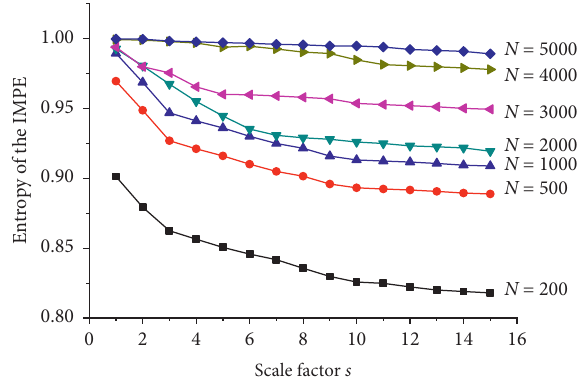
Figure 4: Variation of white noise entropy value.